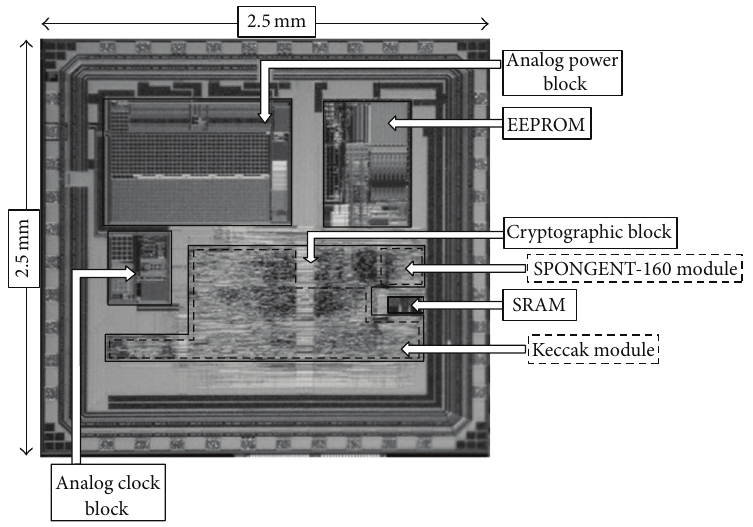
Figure 2: Micrograph of the RFID tag chip.